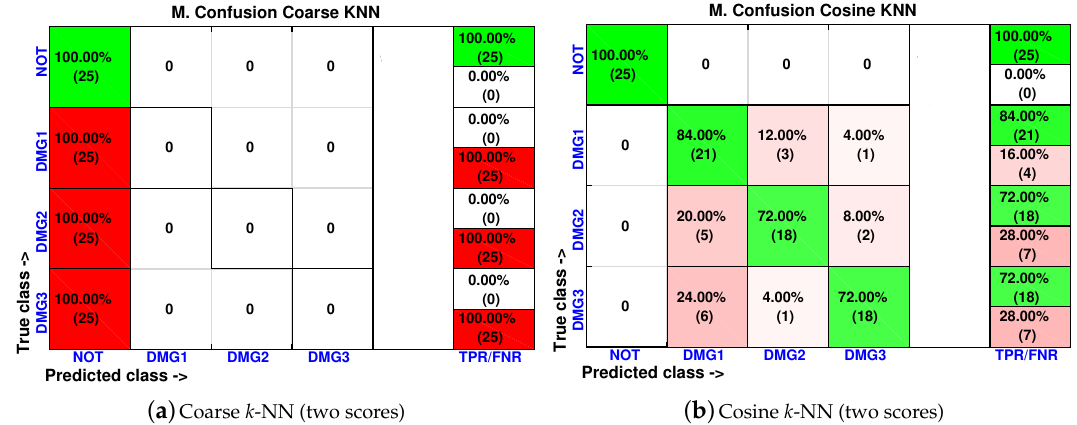
Figure 27. Confusion matrix using coarse k -NN ( a ) and cosine k -NN ( b ) when the feature vector is formed by the first two principal